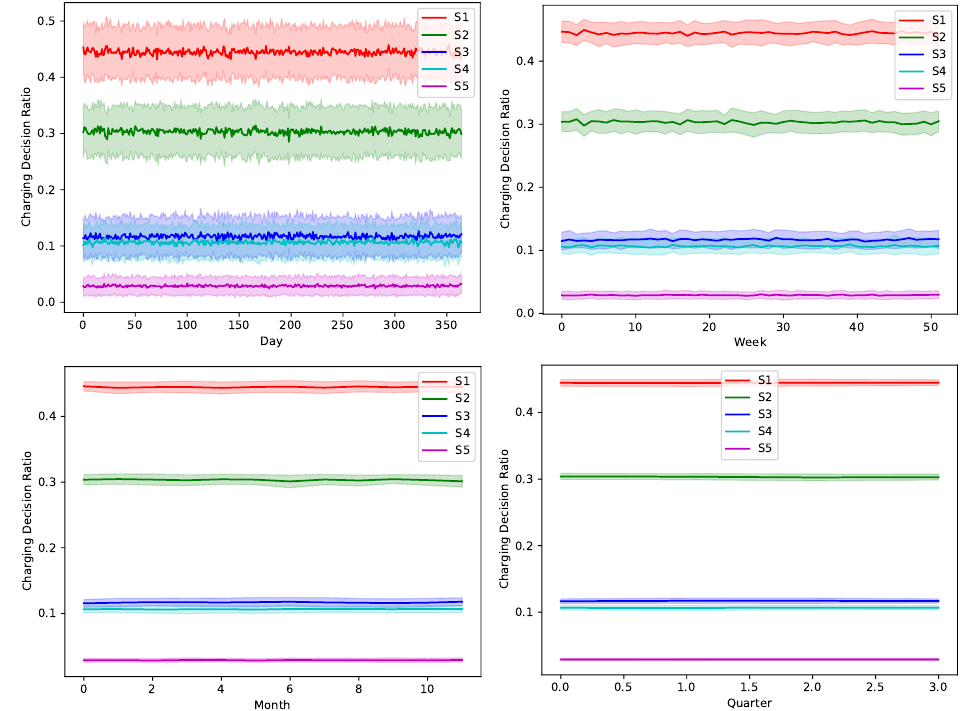
Figure 11. The temporal variation of the adopted charging decision by the greedy algorithm with a global certainty level U 75